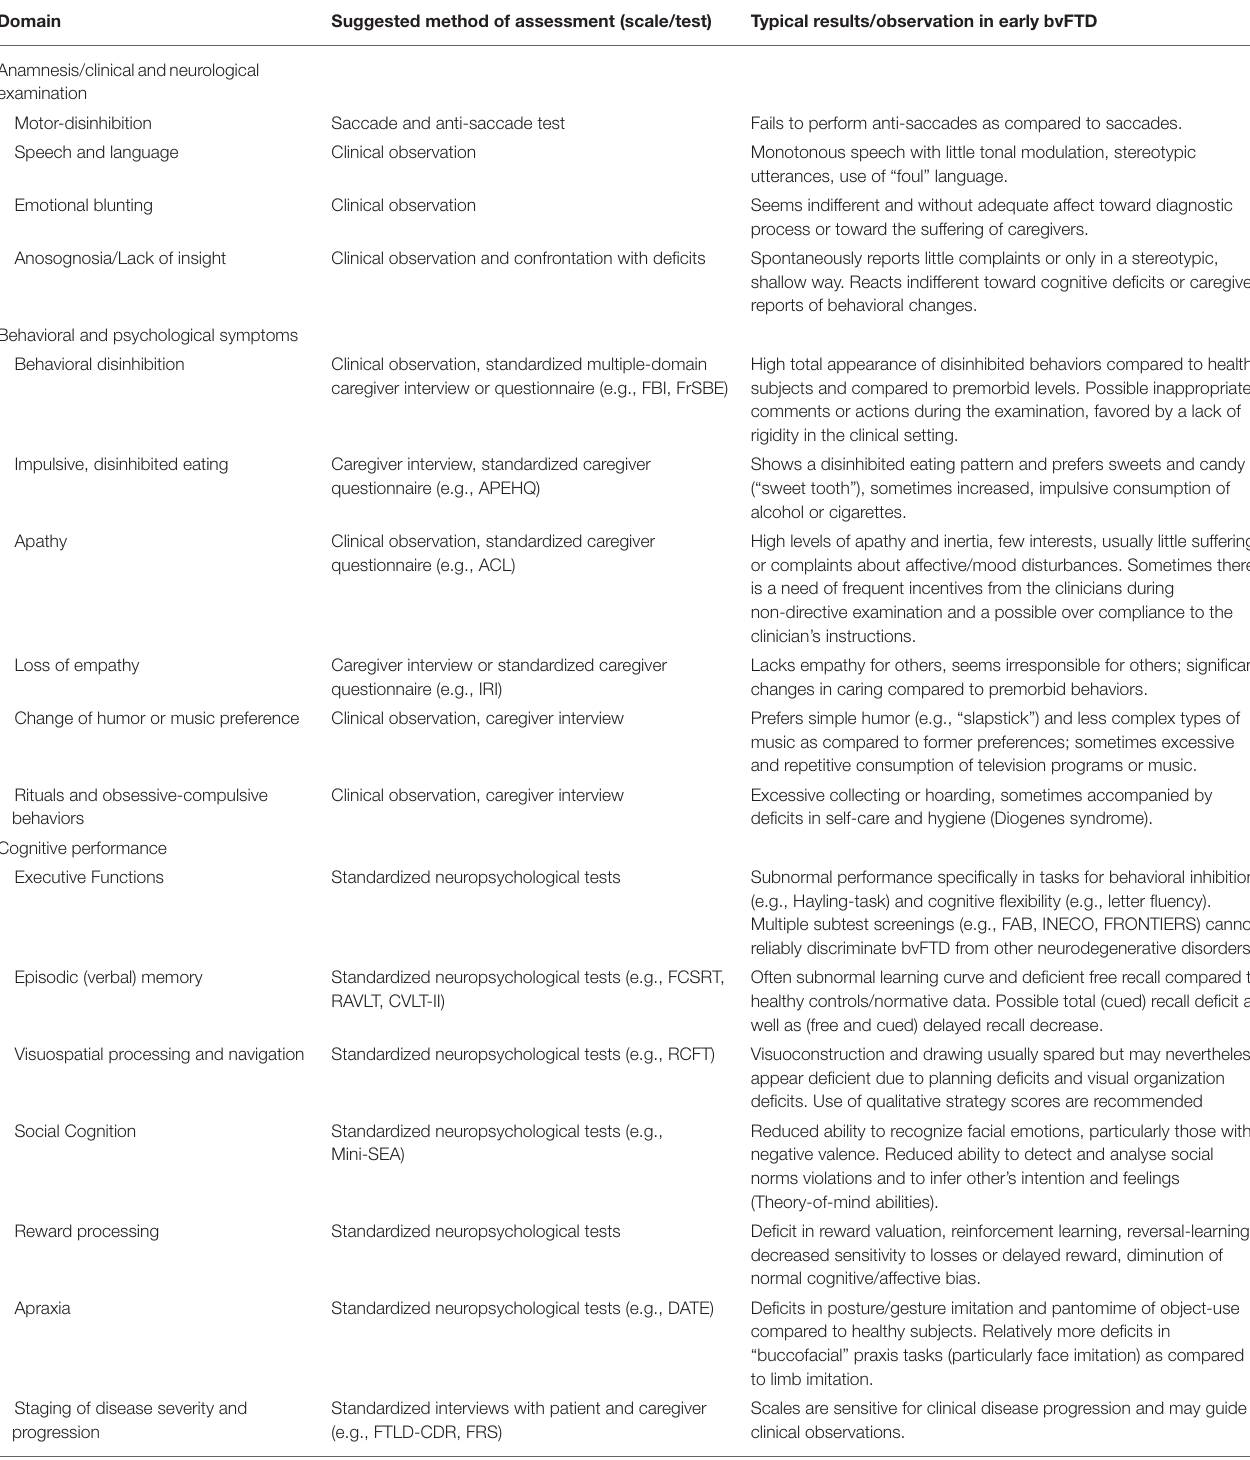
TABLE 1 | Clinical, behavioral, psychological, and cognitive diagnostic domains for